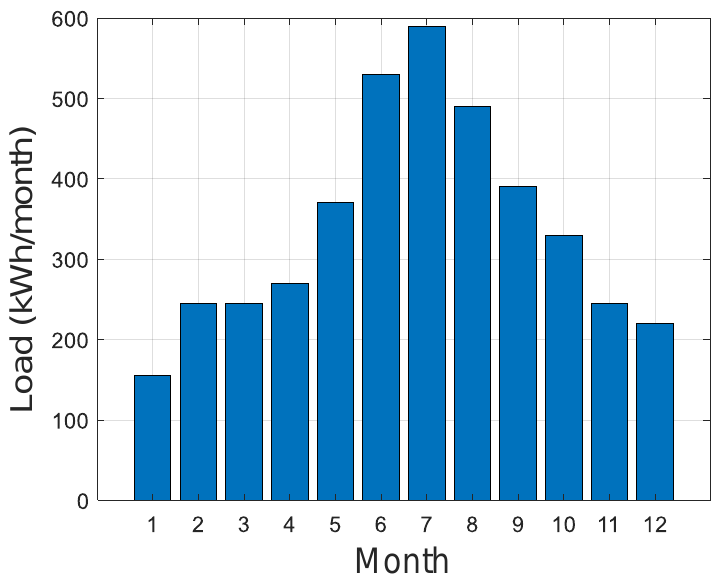
Figure 7. Load monthly consumption.